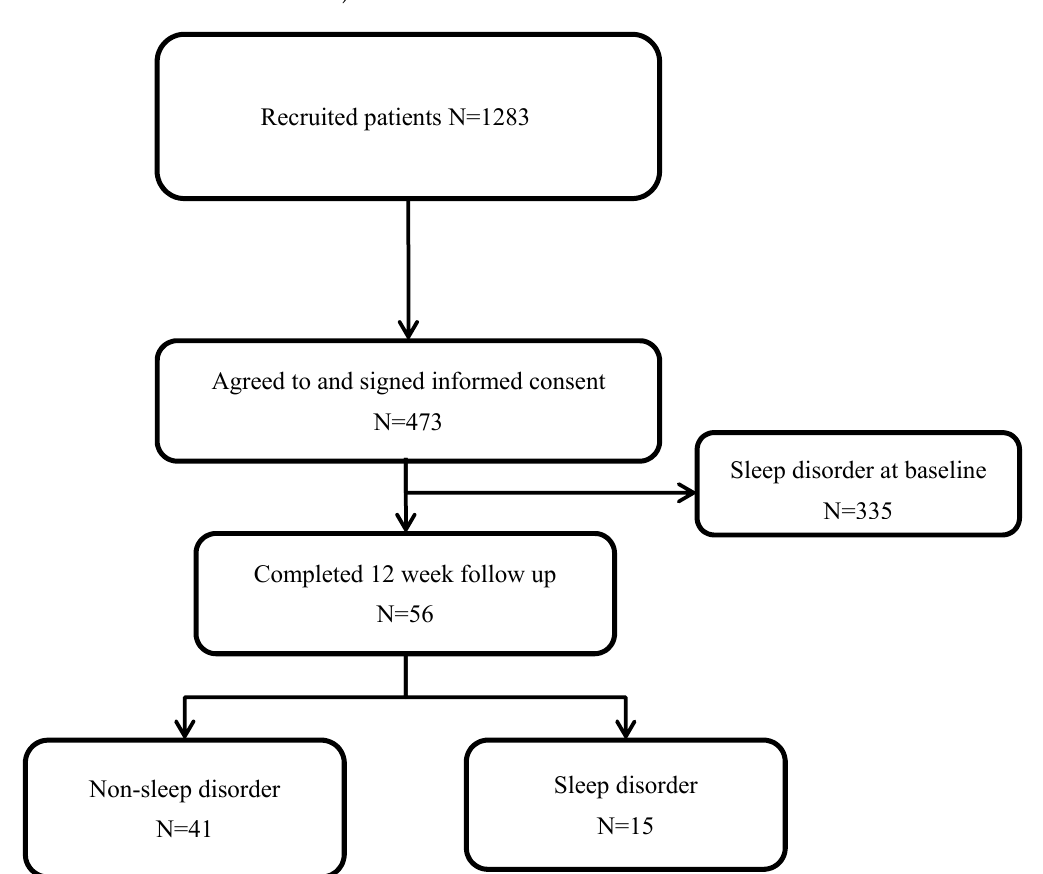
Figure 1. Flow chart of patient inclusion. Inclusion criteria: (1) head injury with GCS > 12; (2) negative brain computed tomography findings; (3) older than 20 years; and (3) no history of brain injury. Exclusion criteria: (1) the patient was pregnant; and (2) the patient suffered from sleep problems at the initial assessment.